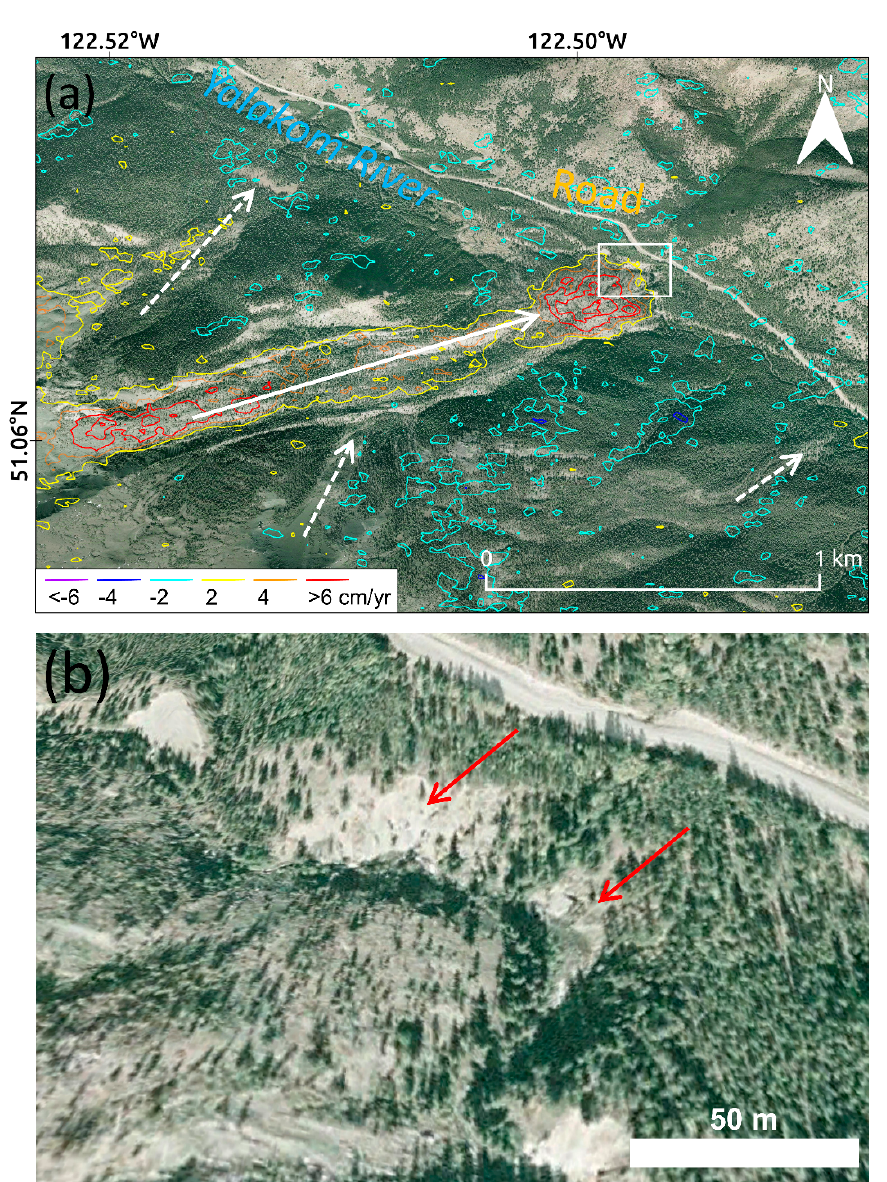
Figure 11. Earthflows at Yalakom River on Google Earth imagery ( a ) and its close-up view of the toe of the largest earthflow ( b ). The color-coded contours are the east–west movement rates estimated by Sentinel-1. The white rectangle represents the extent of Figure 11(b). The largest earthflow (solid white arrow) and surrounding smaller earthflows (dashed white arrows) are also represented in Figures 3, 5b, 7a, and 8. Sediments at the toe of the largest earthflow have diverted the river channel, which is causing riverbank erosion on the east side of the river channel (solid red arrows), next to the road.